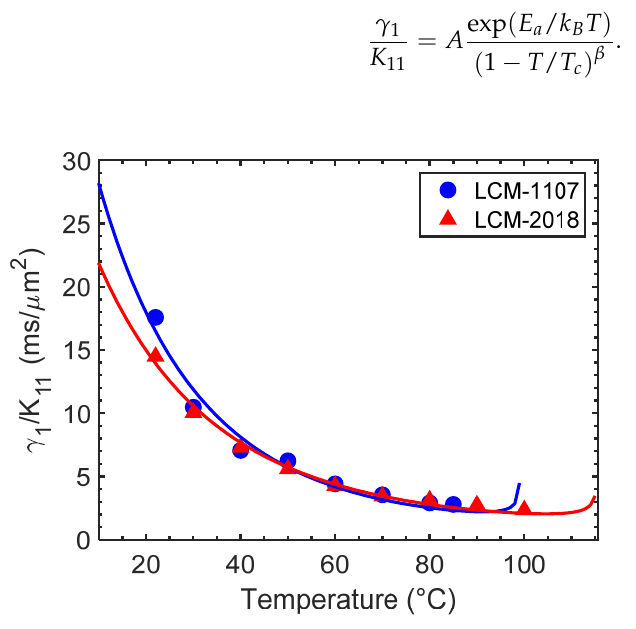
Figure 5. Temperature-dependent viscoelastic constant of LCM-1107 and LCM-2018. Dots and triangles are measured data and solid lines are fitting curves with Equation (3).